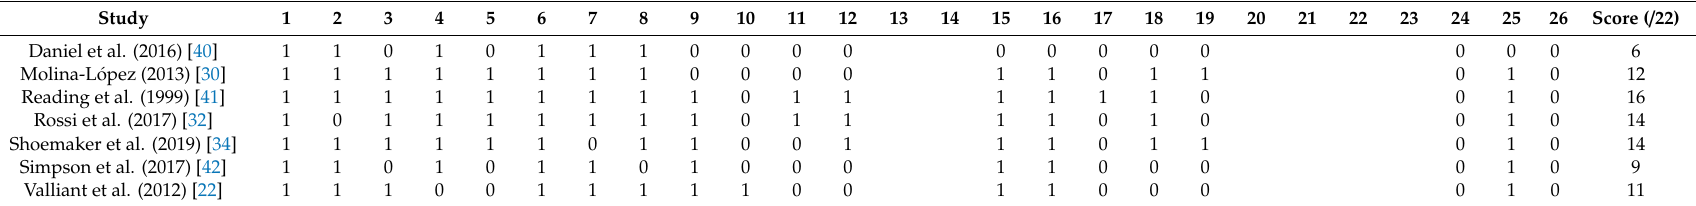
Table 5. Methodologic quality of the included single-arm studies.